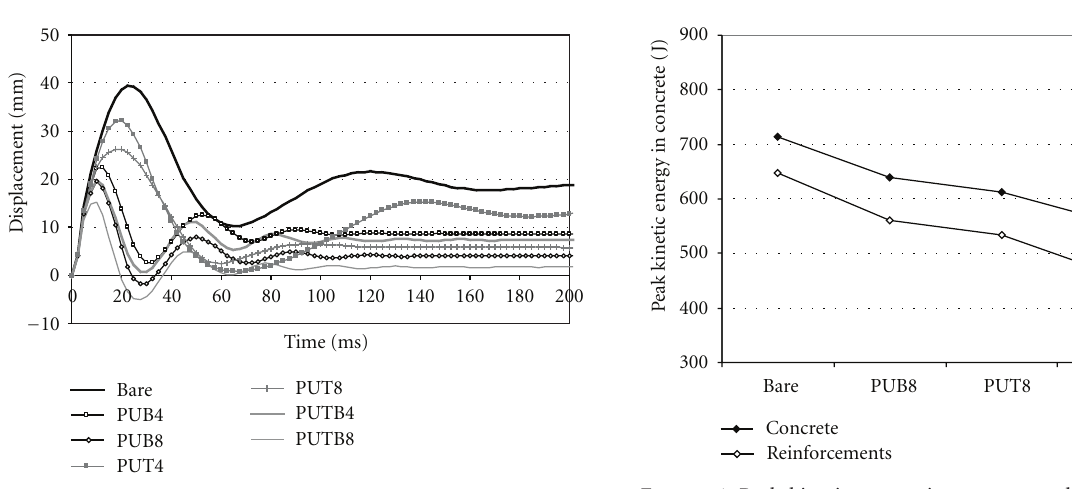
Figure 5: Displacement-time histories of the bare panel and various polyurea coated panels.